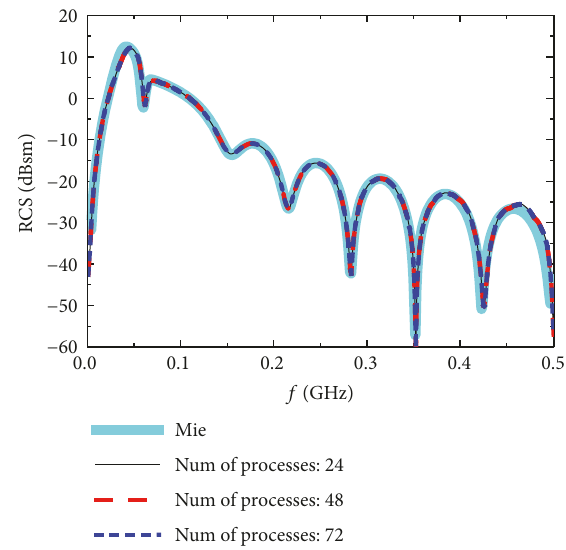
Figure 6: Monostatic RCS of plasma sphere.